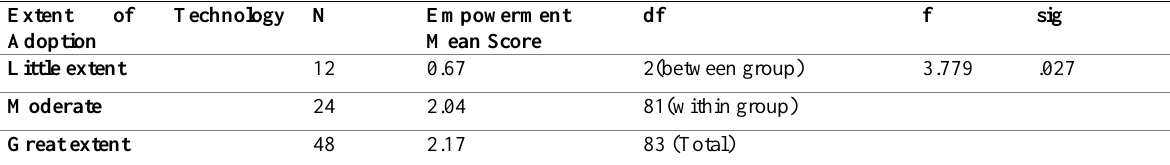
Table 8. Table 8: Influence of Technology Policy on Youth Economic